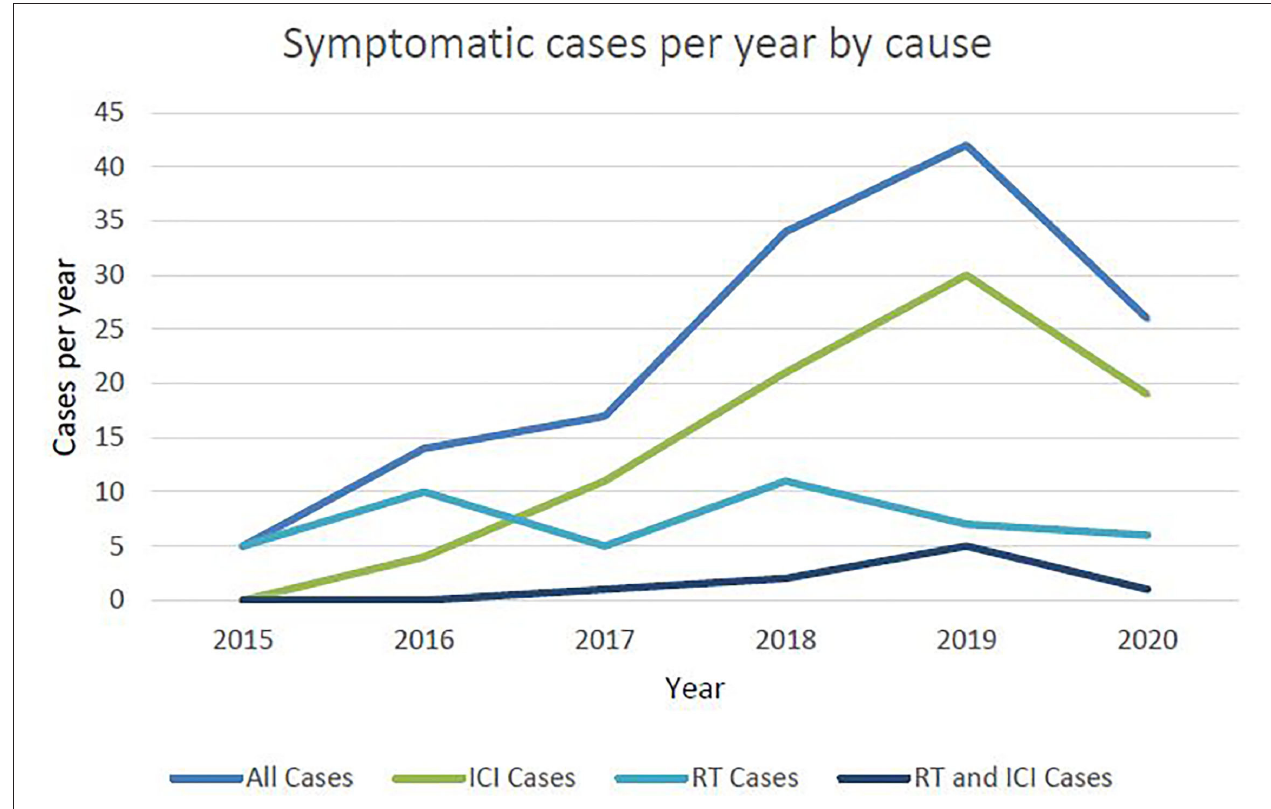
FIGURE 3 | Number of symptomatic cases per year by cause.